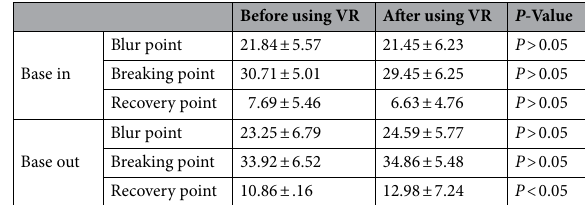
Table 2. The NHV changes with Base in and out, in unit Prism, before and after the use of VR for watching 3D videos.